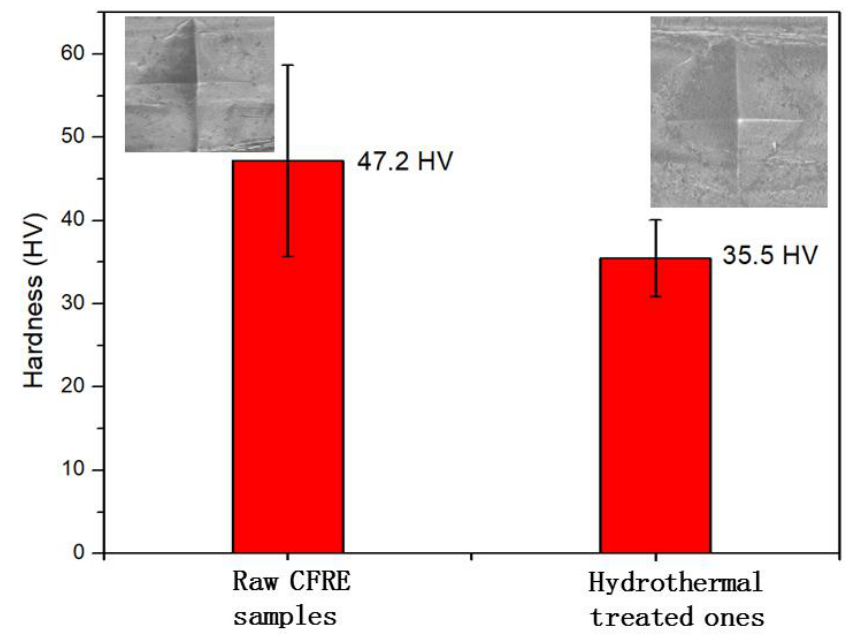
Figure 8. The micro-hardness of CFRE specimens before and after saturated moisture absorption through hydrothermal